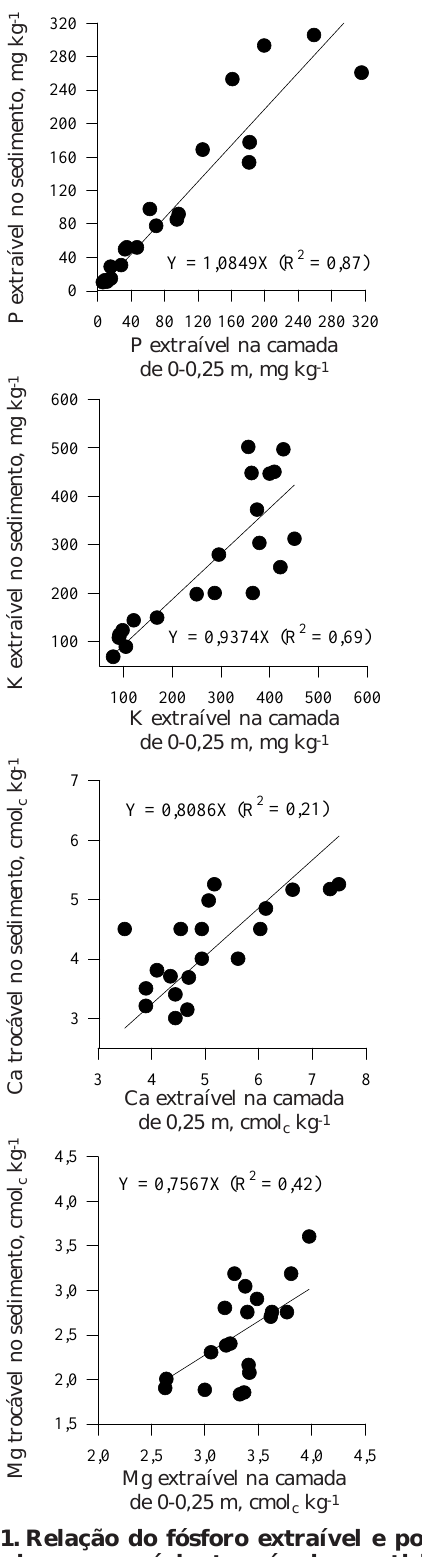
Figura 1. Relação do fósforo extraível e potássio, cálcio e magnésio trocáveis contidos na camada de 0-0,025 m de profundidade do solo e no sedimento da erosão hídrica, em três ciclos culturais num Cambissolo Húmico alumínico (média da rotação e sucessão de culturas).